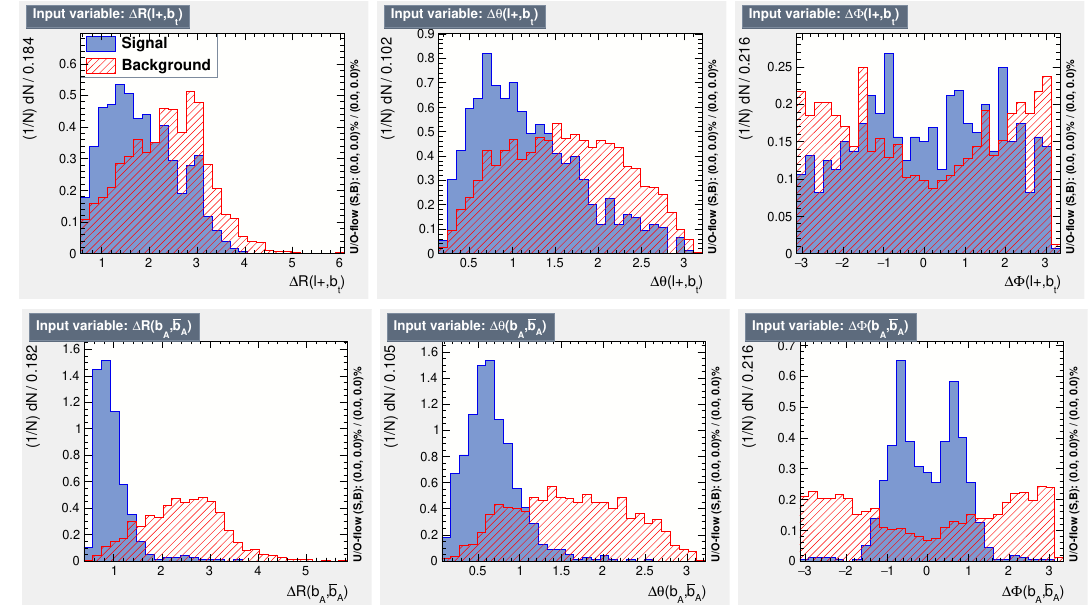
Figure 7. Distributions of the TMVA input variables for the signal (blue) and background (red) samples for t (cid:22) tA events with m A = 40 GeV. The angular variables (cid:1) R , (cid:1) (cid:18) and (cid:1)(cid:8) for the pairs ( l + ; b t ) (top) and ( b A ; (cid:22) b A ) (bottom) are computed at parton level.